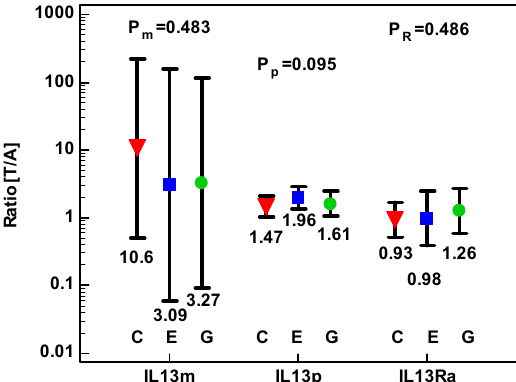
Figure 7. Effect of anatomical site on tumor-to-adjacent expression ratios of IL13 mRNA (IL13m), IL-13 protein (IL13p), and IL13Ra1 . Data analyzed as logs using one-way ANOVA and presented as geometric means with 95% confidence interval (whiskers). Red triangles represent mean values in colorectal cancers (denoted as C); blue squares represent mean values in esophageal squamous cell carcinoma (denoted as E); green circles represent mean values in gastric adenocarcinoma (denoted as G). p values for IL13 mRNA analysis are denoted as P m , for IL-13 protein analysis as P p , and for IL13Ra1 mRNA analysis as P R .